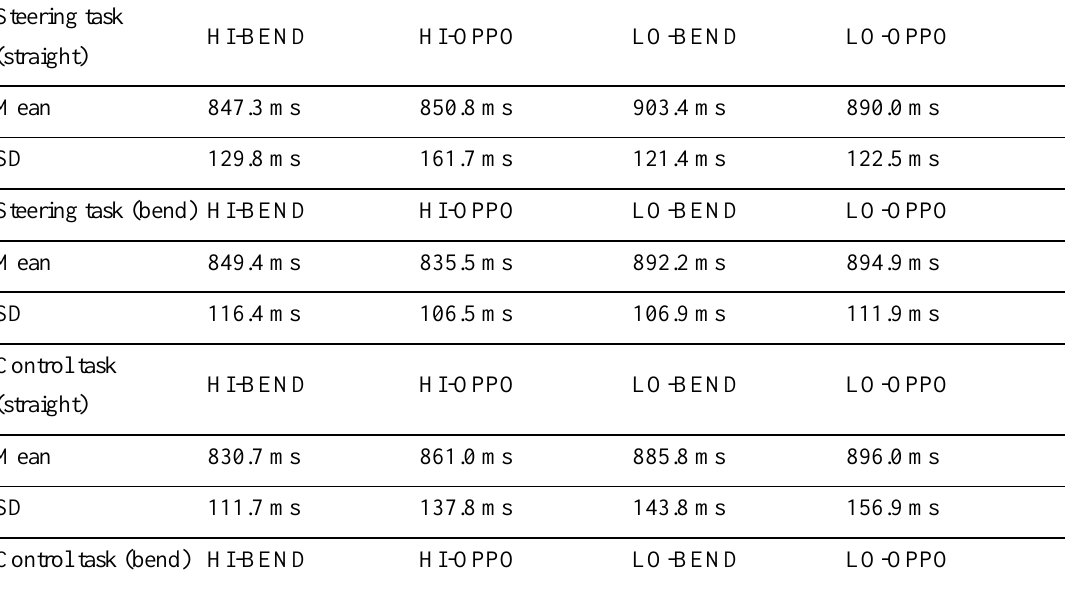
Table 4. Mean reaction times (of participant medians) and standard deviations for the different target loca- tions in bends and on straights in both the steering and control